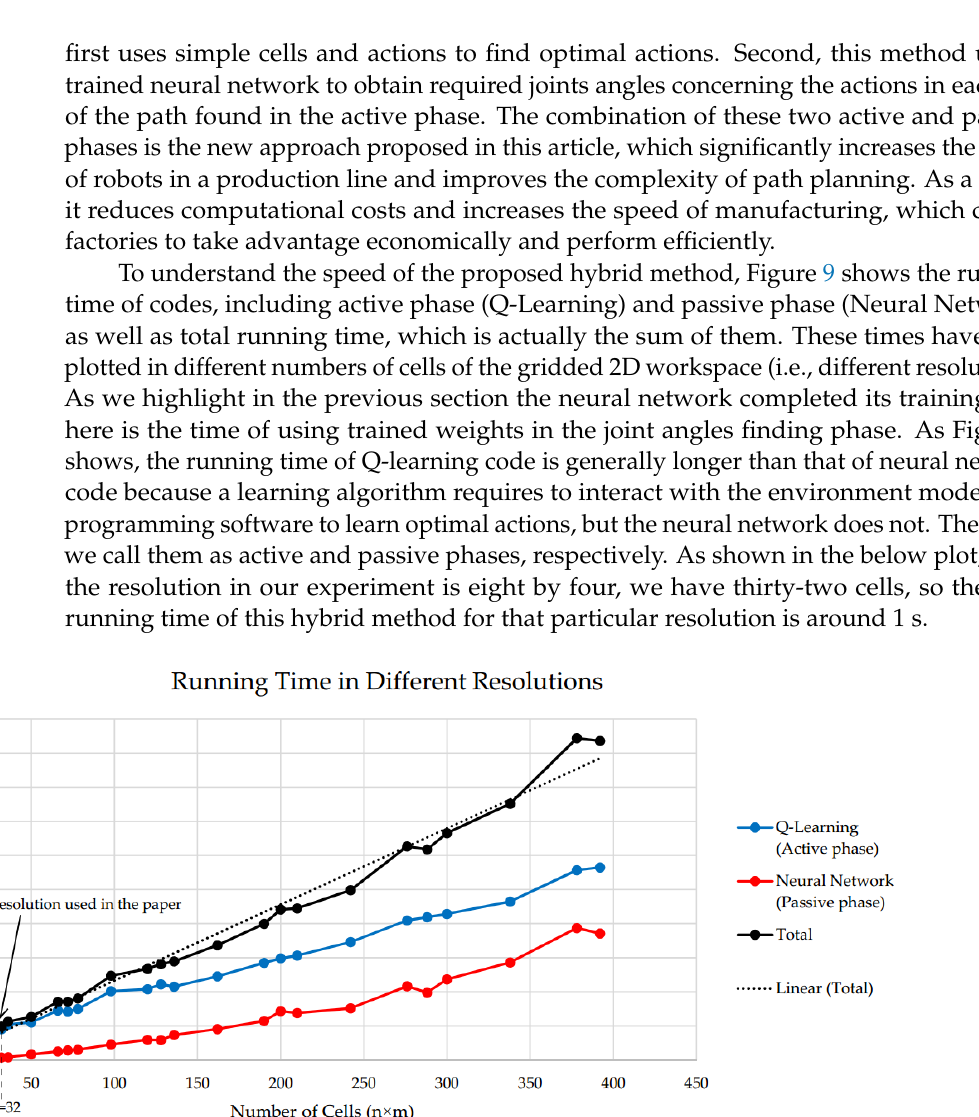
Figure 10. ( a – p ) Different configurations with their paths: blue arrows represent the sequence of actions in each cell from the start cell to the target cell.